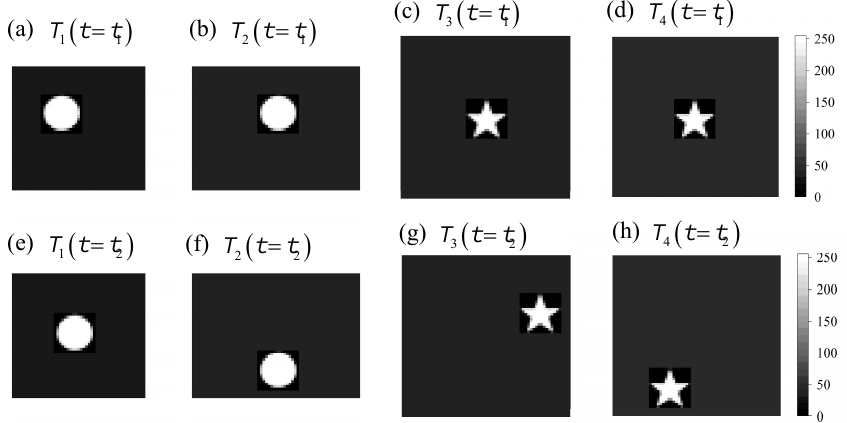
Figure 7. The four window functions: ( a – d ) are the images at the moment t 1 , and ( e – h ) are the images at the moment t 2 ; ( a , e ) represent target T 1 , ( b , f ) represent target T 2 , ( c , g ) represent target T 3 , and ( d , h ) represent target T 4